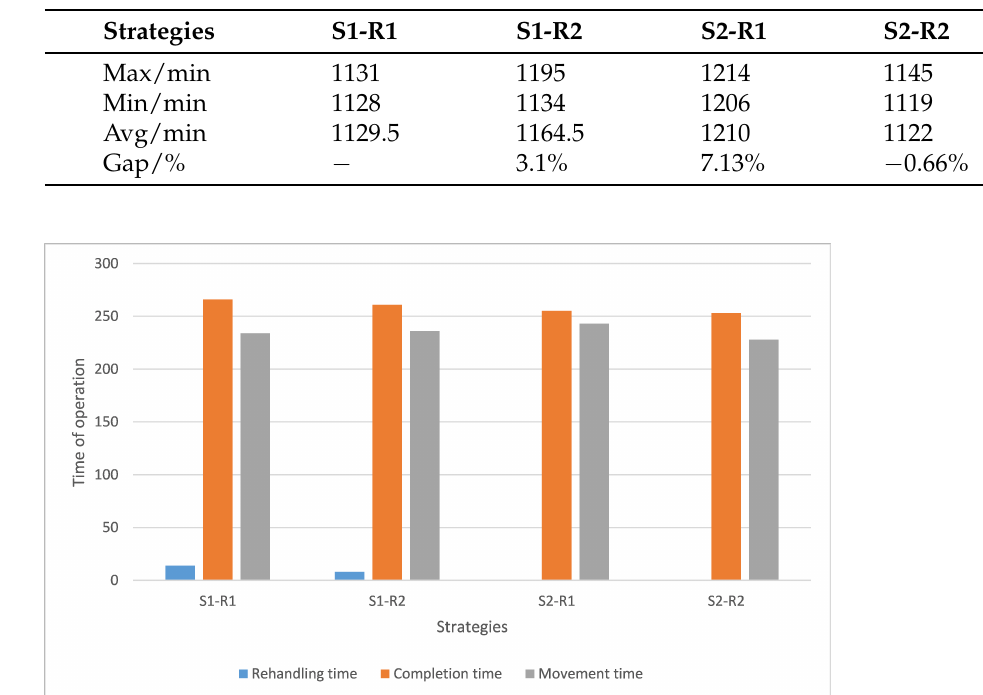
Figure 11. Evaluation index of MP-MBPP.